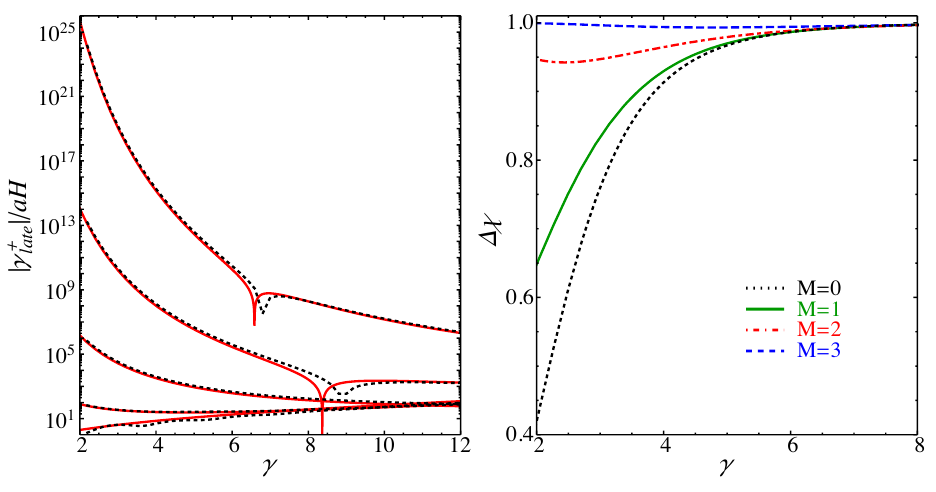
Figure 8 . Left: comparison between the late-time amplitude of the positive-helicity gravitational waves computed analytically (red-solid) and numerically (black-dotted) for M = 1 ; 3 ; 5 ; 7 ; 9 (bottom to top) and (cid:15) = 0 : 01. Right: the chirality parameter as a function of (cid:13) for (cid:15) = 0 : 01 and di(cid:11)erent values of M